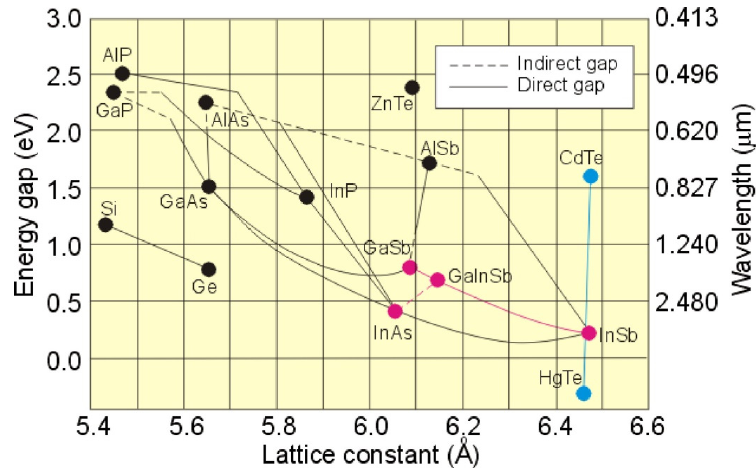
Figure 1. Composition and wavelength diagram of semiconductor material systems (Reprinted from [Rogalski, A.; Antoszewski, J.; Faraone, L. Third-generation infrared photodetector arrays. J. Appl. Phys. 2009 , 105 , 091101, doi:10.1063 / 1.3099572], with the permission of AIP Publishing). While the InSb has narrow band gaps in the mid-wave IR (MWIR), where it dominates as a semiconductor for PDs, PDs based on Hg 1-x Cd x Te (MCT) have the great advantage of being able to tune the wavelength of operation from MWIR to long-wave IR (LWIR), adjusting the